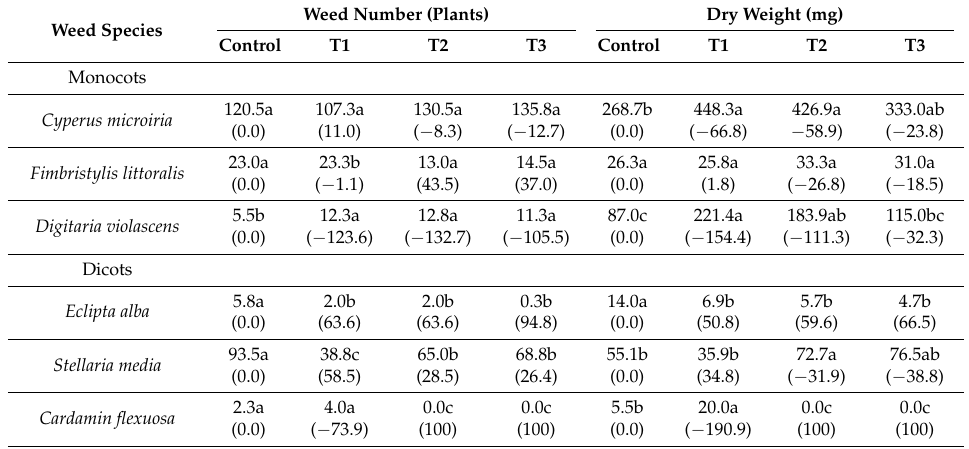
Table 6. Effects of C. crenata dried leaf powder on the emergence of weeds in the natural soil in a greenhouse.